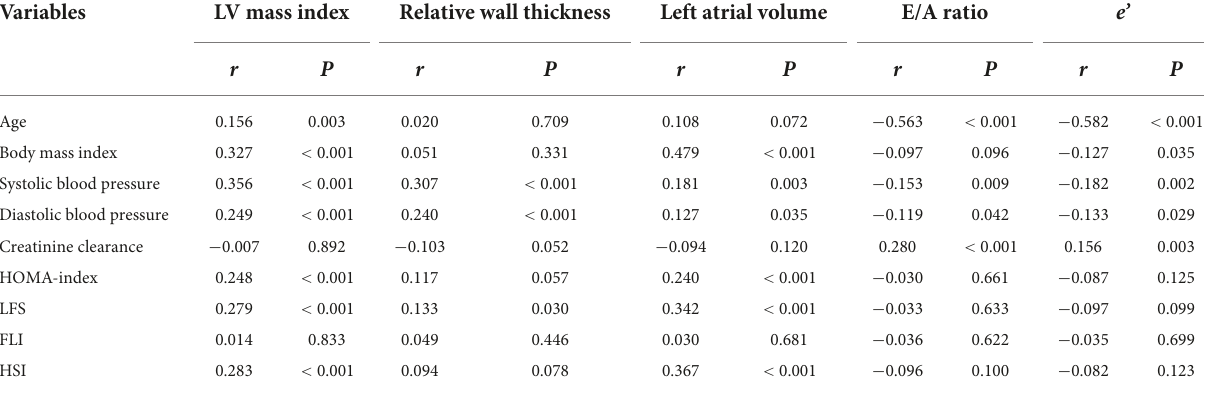
TABLE 4 Univariate correlations with echocardiographic indexes as the dependent variables in hypertensive patients.